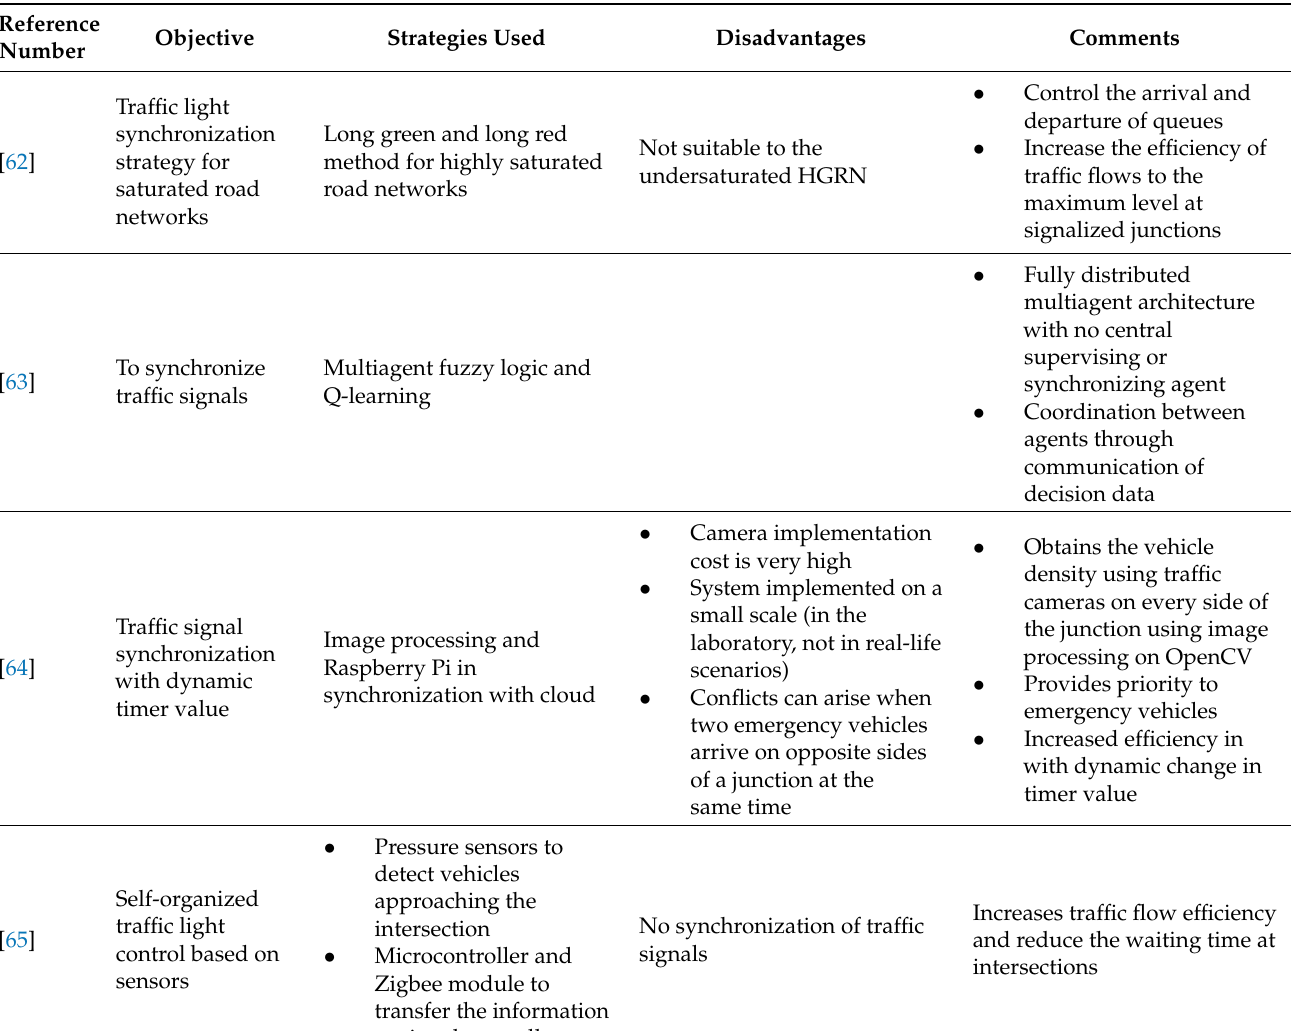
Table A1. Categorization of existing literature on synchronization of traffic